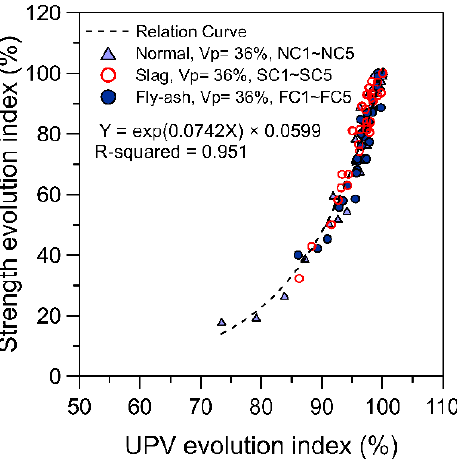
( b ) Figure 6. Effects of adding pozzolanic admixture and altering the paste volume ratio on the UPV and strength evolution index: ( a ) fly ash concrete; ( b ) slag concrete. To evaluate the difference between normal concrete and concrete with pozzolanic material, the data of normal concrete specimens (NC1–NC5) with identical paste volume ratios ( V p = 36%) and sand–aggregate ratios (S/A = 45%) were combined with the data of pozzolanic concrete for analysis. Figure 7 displays the relationship between the UPV and strength evolution index for specimens NC1–NC5, FC1–FC5, and SC1–SC5. The terminal UPV and strength data for the normal and pozzolanic concrete were the test results at 28 and 70 days, respectively. Figure 7 demonstrates that the data points for the UPV evolu- tion index had a strong correlation with the data points for the strength evolution index.